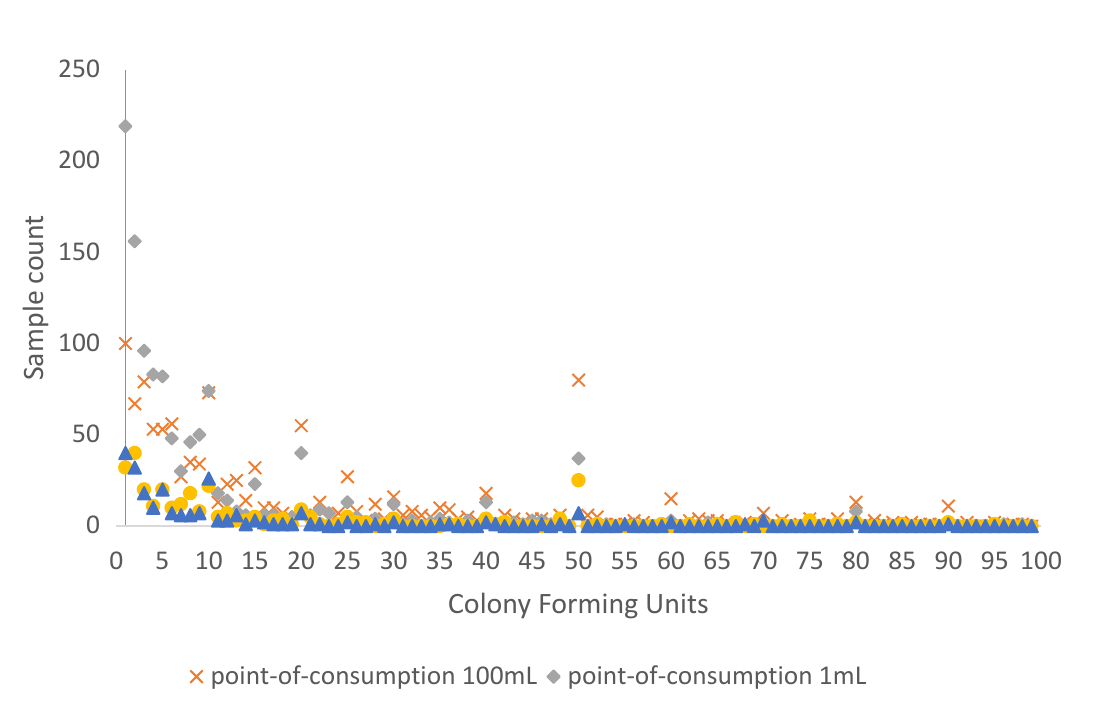
Figure 1. Distribution of E. coli colony-forming unit (cfu) counts from membrane filtration in the range 1 to 99cfu for 1 mL and 100 mL point-of-consumption and source water samples.